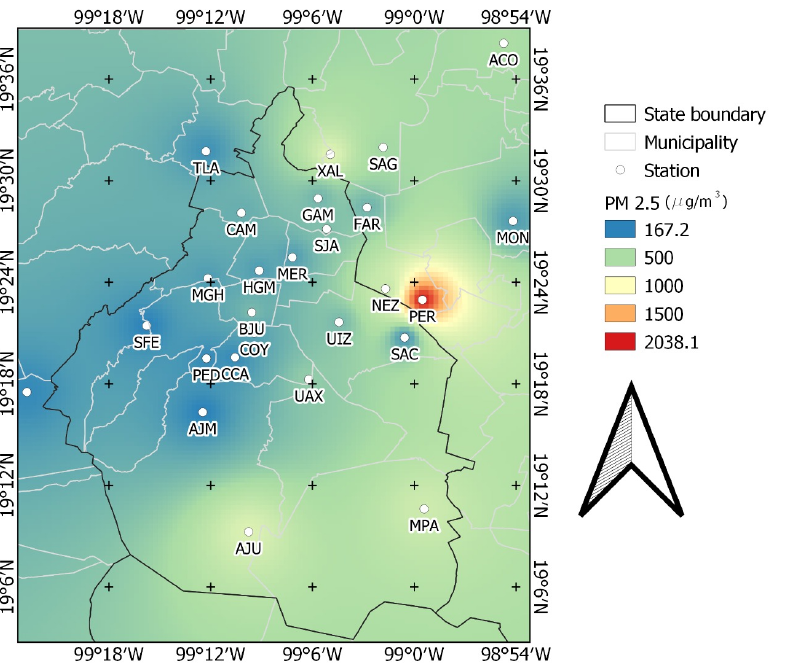
Figure 7. Spatial distribution of PM2.5 for a return period of 25 years for the study region.